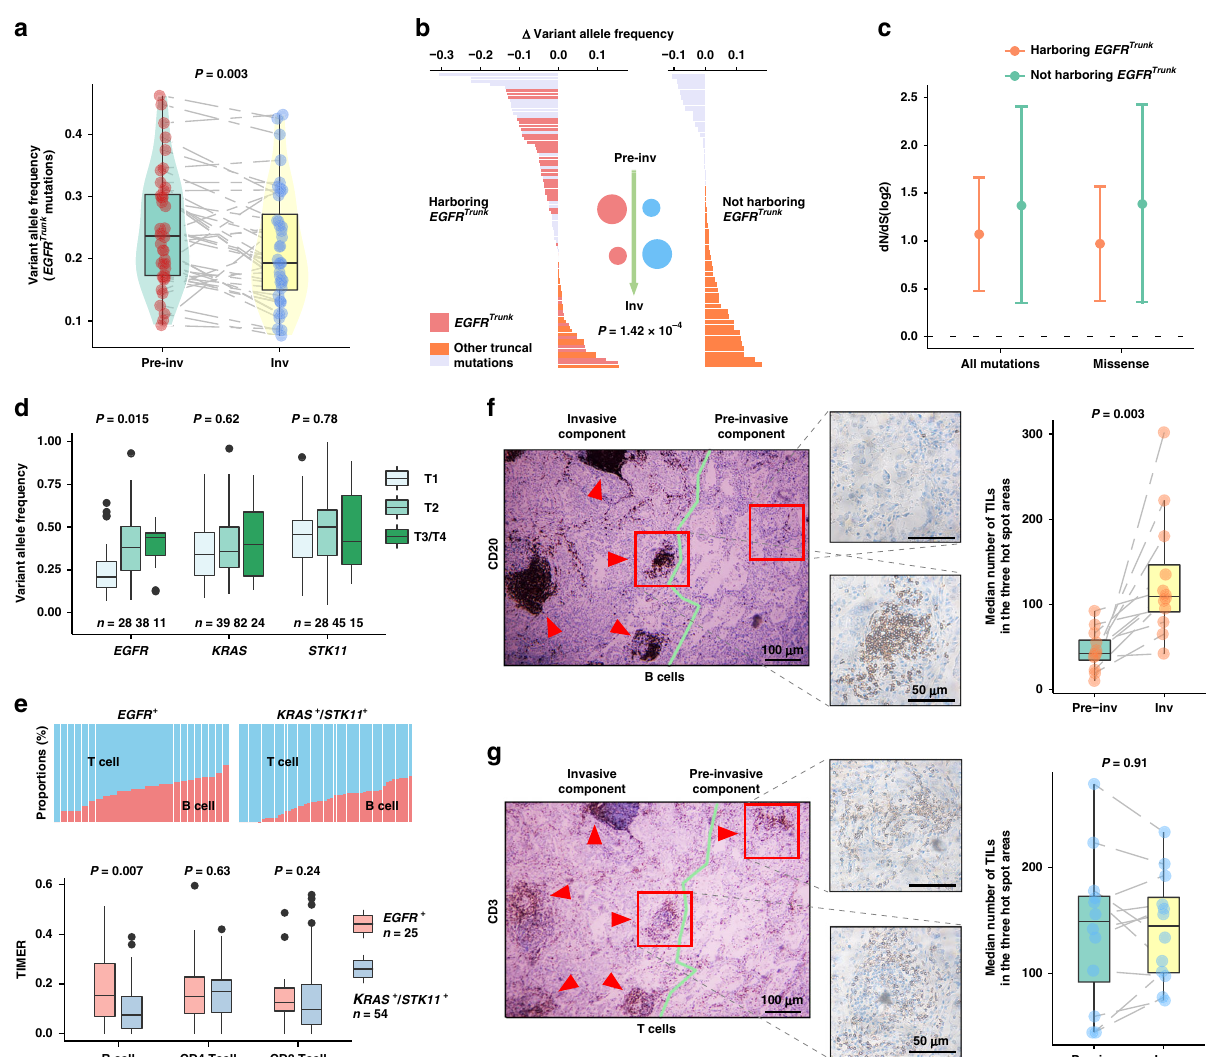
Fig. 4 Strong selective pressure derived from B cell in fi ltration in MPNs harboring truncal EGFR mutation. a Variant allele frequency (VAF) of identi fi ed truncal EGFR mutations in 36 paired pre-invasive and adjacent invasive components. Differences were assessed using the two-sided Wilcoxon rank-sum test. b Mutant abundance change of identi fi ed truncal mutations between two components in EM2, according to whether they harbored truncal EGFR mutations. Red and blue circles represent the putative truncal clone abundance of two groups during the invasive progression, respectively. P value was derived from two-sided Wilcoxon rank-sum test. c The d N /d S ratios inferred for 36 MPNs harboring and 11 MPNs not harboring truncal EGFR mutations. These ratios were obtained as described for Fig. 3b. Circles and vertical lines correspond to the mean and 95% con fi dence intervals of the d N /d S ratio, respectively. d Mutation abundance in EGFR , KRAS , and STK11 mutations in the TCGA LUAD data for patients of stages T1 – 4. Differences among stages were assessed by Kruskal – Wallis H test. e Comparisons of T cells and B cells between EGFR- and KRAS/STK11 -mutated groups using TIMER in fl ammatory in fi ltration in T1 stage cases of TCGA. P value, two-sided Wilcoxon rank-sum test. f , g Representative sliced IHC images of B cells f and T cells g in 12 EGFR - mutated patients. Two-sided Wilcoxon rank-sum test was used for paired invasive and pre-invasive components. Bar, median; box, 25th – 75th percentiles (interquartile range, IQR); vertical line, data within 1.5 times the IQR. Inv Invasive and Pre-inv